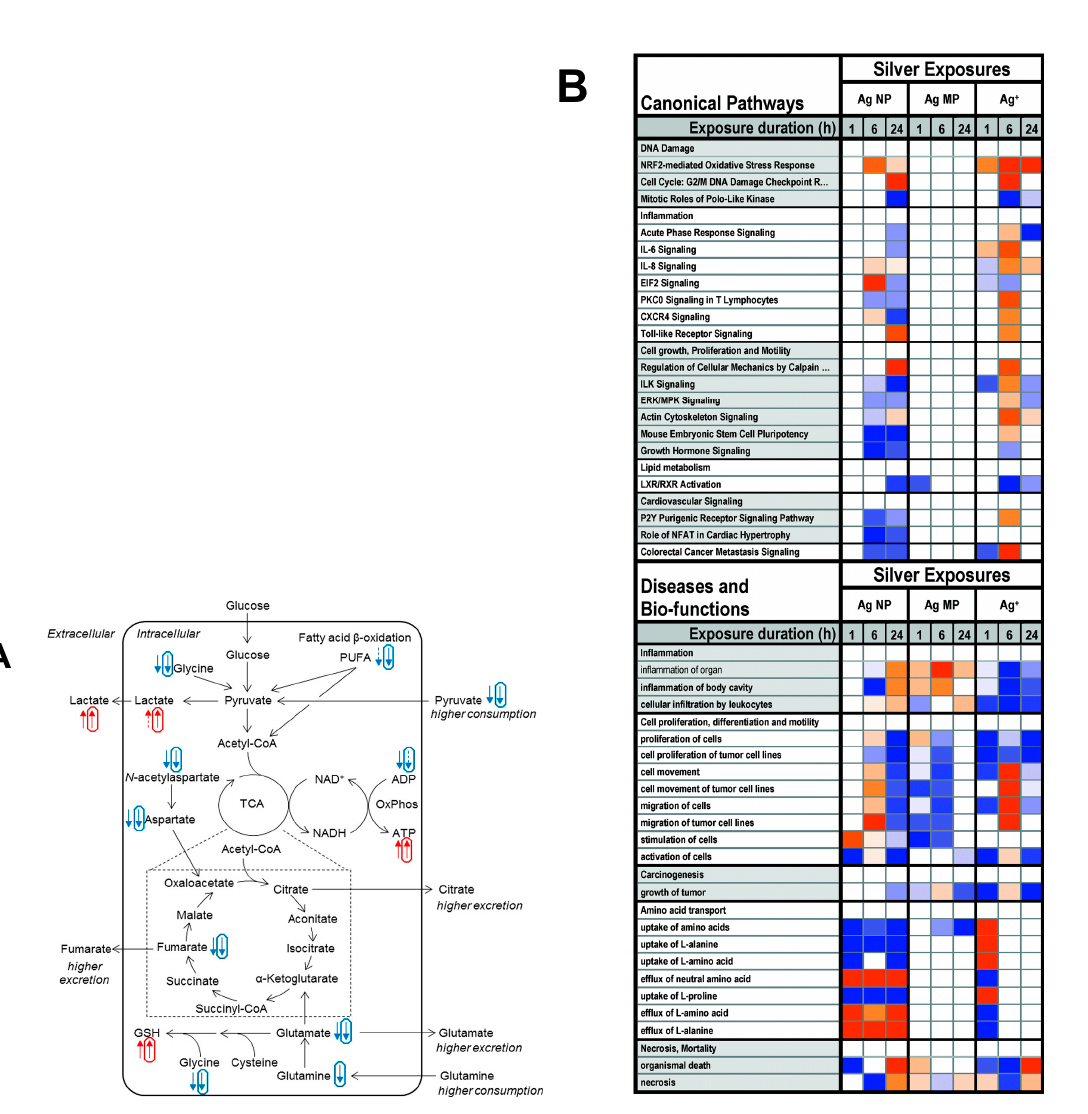
Figure 8. ( A ) Metabolic impacts of AgNPs exposure on energy changes (glycolysis and the TCA cycle) in cancer cells. As equated with controls, normal and rounded arrows signify e ff ects